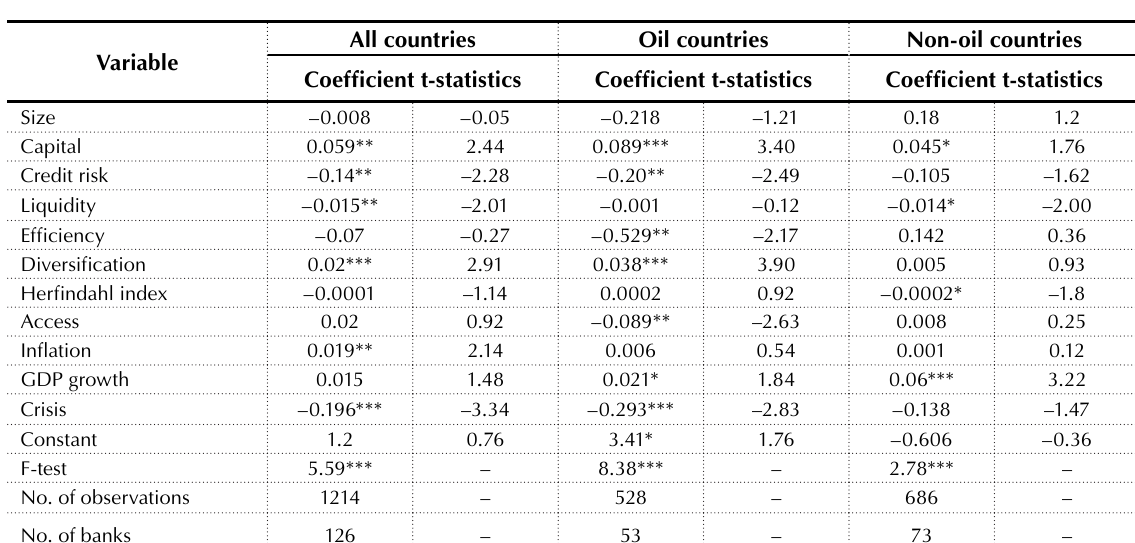
Table 5. Fixed effects results (total banks sample)